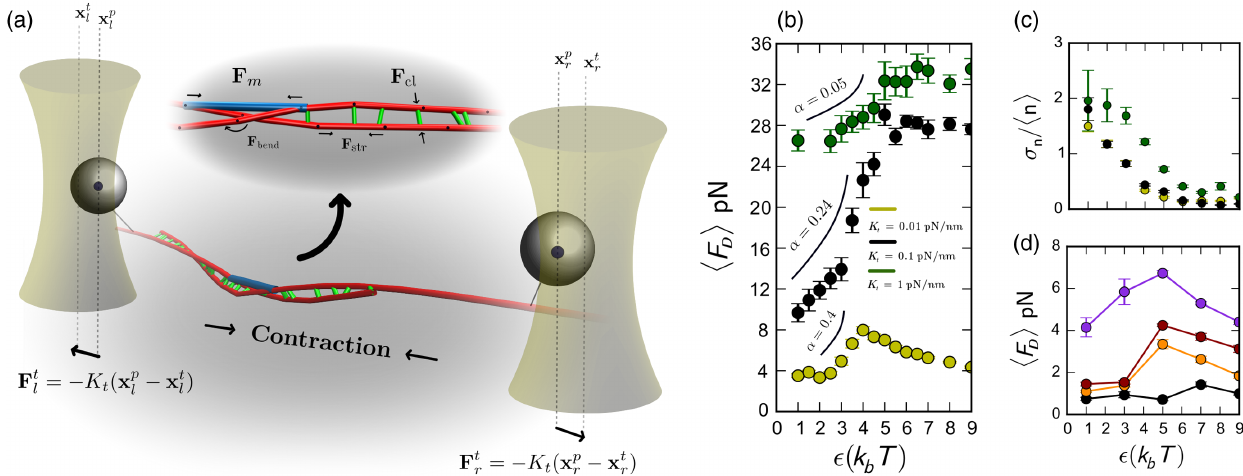
FIG. 7. A three-dimensional force dipole simulated using MEDYAN , an active matter reaction-diffusion model. (a) A schematic of the simulation setup, very similar to the one-dimensional model shown in Fig 2. Two filaments (red), now containing three-dimensional ¼ ð 0 ; 0 ; 0 Þ μ m and x p ¼ ð 4 ; 0 ; 0 Þ μ m, respectively, at t ¼ 0 ] are bending and stretching modes, are oriented so that their plus ends [ x p r l ¼ x t connected to elastic, stationary tethers at x t and x t (initially x p ). As contraction is produced by myosin II filaments (blue) r l l;r l;r walking towards the plus ends of each actin filament, cross-linkers (green) and actin filaments can bend and stretch according to polymer i , is shown as a function of ϵ . The steady-state data potentials outlined in Appendix D. (b) The averaged dipole force after 200 s, h F D ∝ ð ϵ P cl Þ α , where α ¼ 0 . 4 , 0.24, and 0.05, respectively, for increasing K follow the power laws F ss . The probability of a o t D